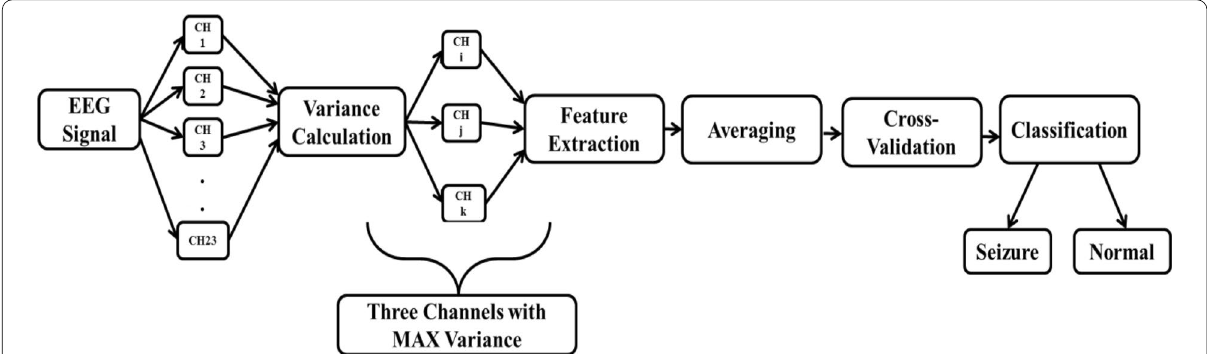
Fig. 1 Block diagram shows the steps of the proposed